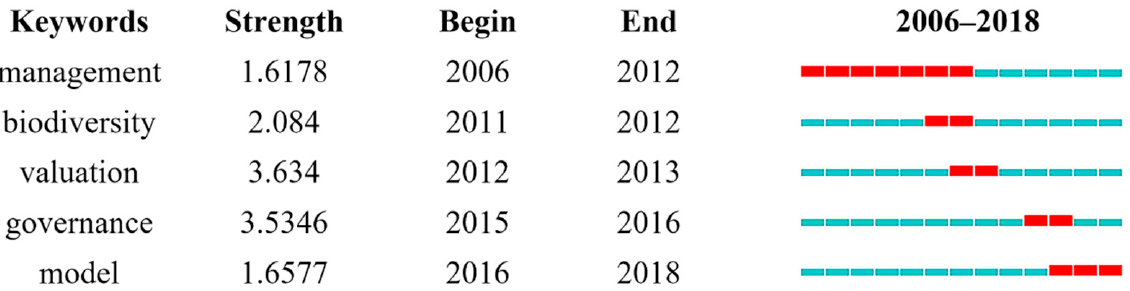
Figure 7. Top-five keywords with the strongest citation bursts. The blue represents the timeline, the red represents the time period in which the keyword appears, and thickness refers to highlighting.